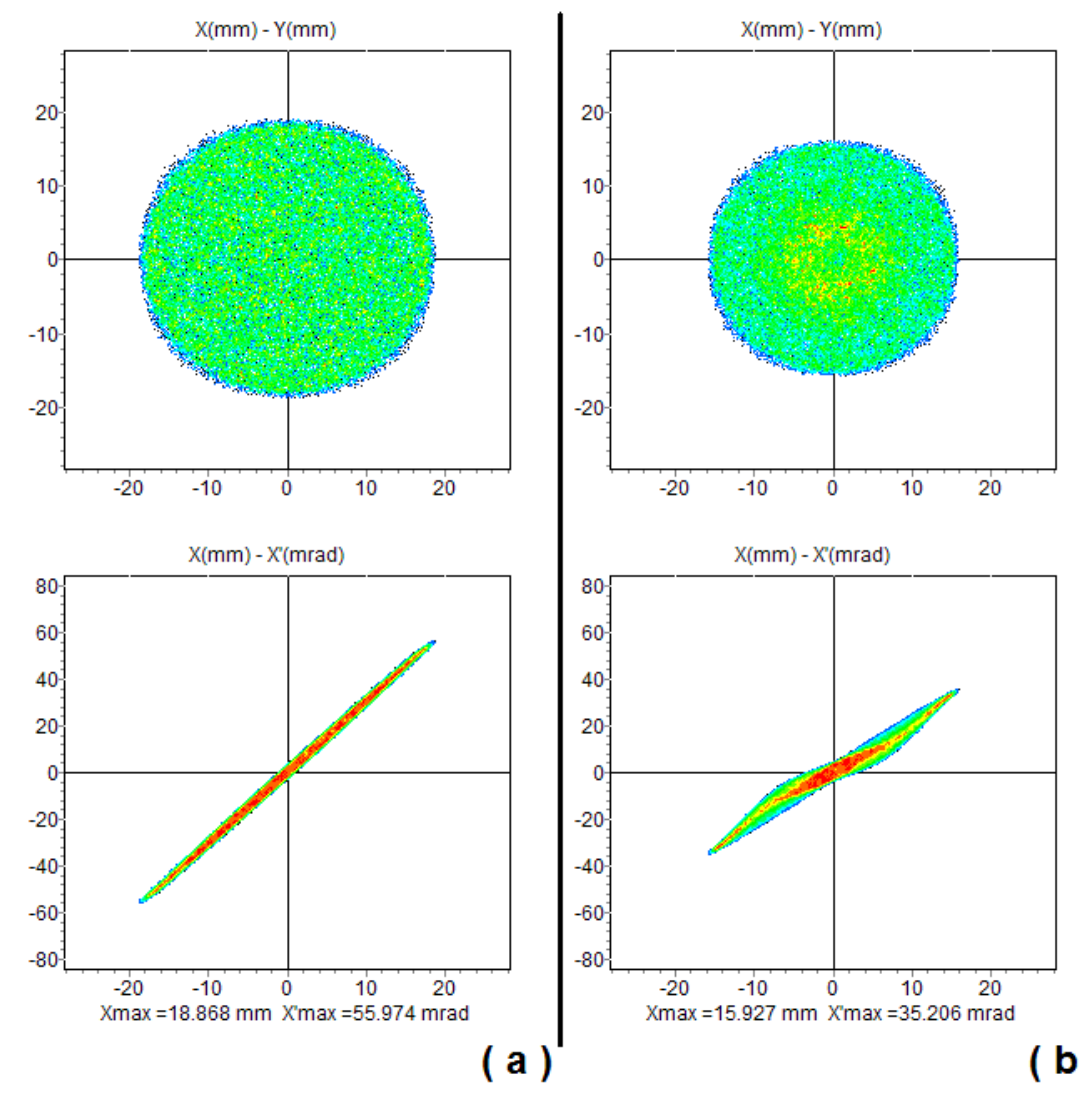
FIG. 12. (Color) The H (cid:1) beam at the drift exit (a) at 58 ns and (b) at 0 : 9 (cid:6) s . Results plotted with PLOTWIN code